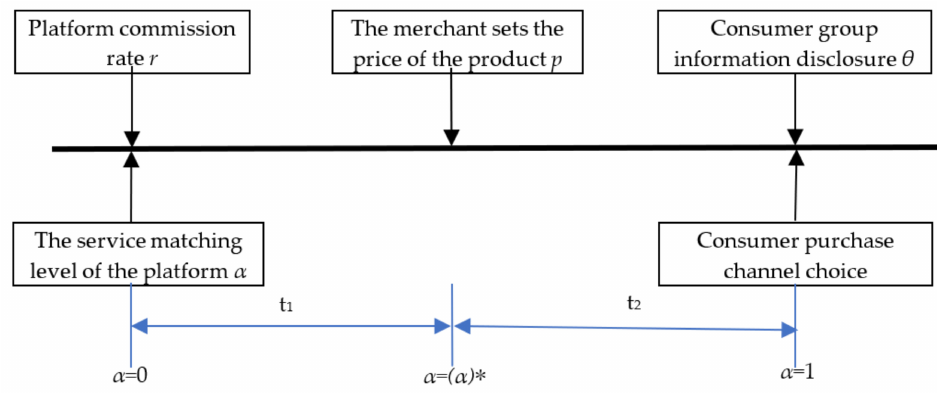
Figure 1. Sequential game